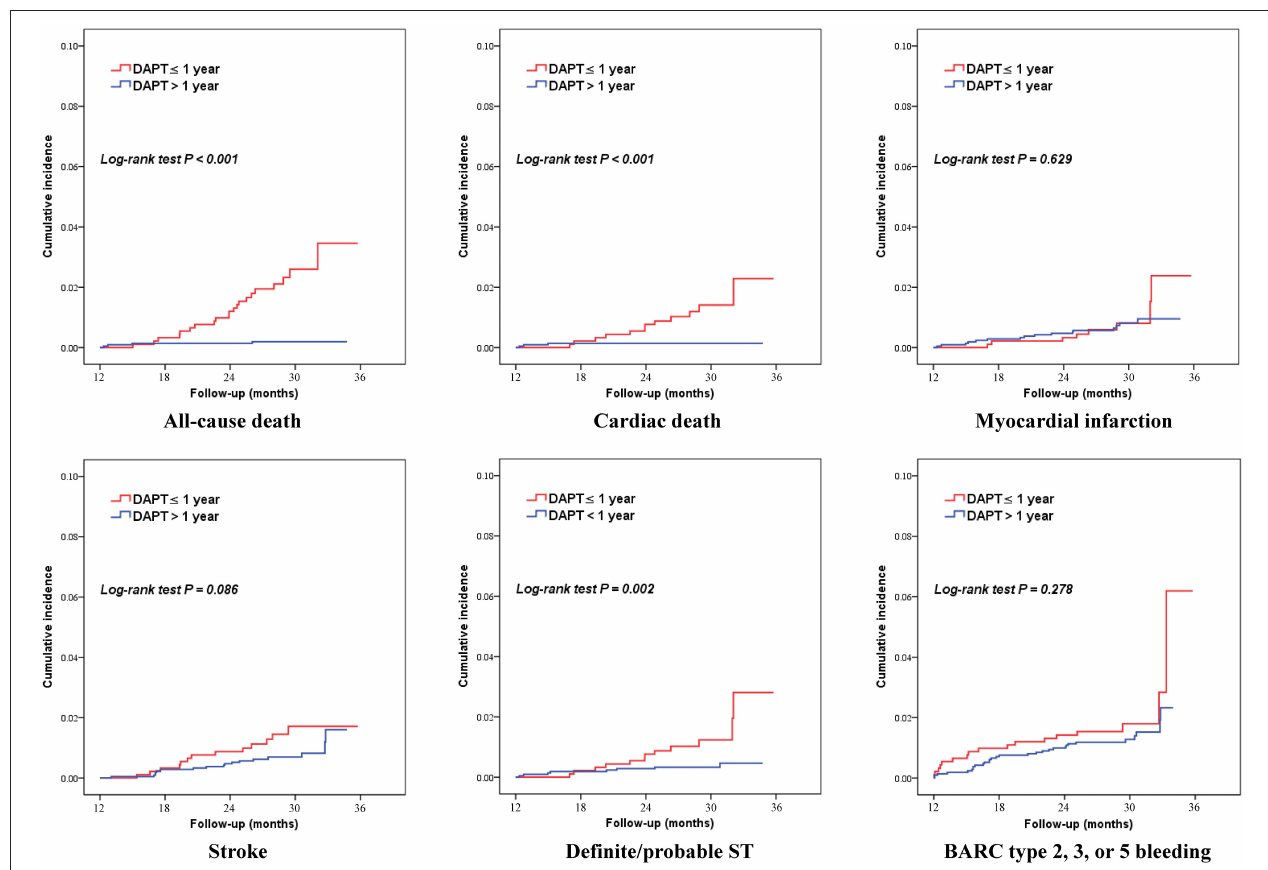
FIGURE 3 | Kaplan–Meier curves for secondary outcomes according to DAPT duration ( > 1 year vs. ≤ 1 year) in patients with elevated Lp(a) levels. BARC, Bleeding Academic Research Consortium; DAPT, dual antiplatelet therapy; ST, stent